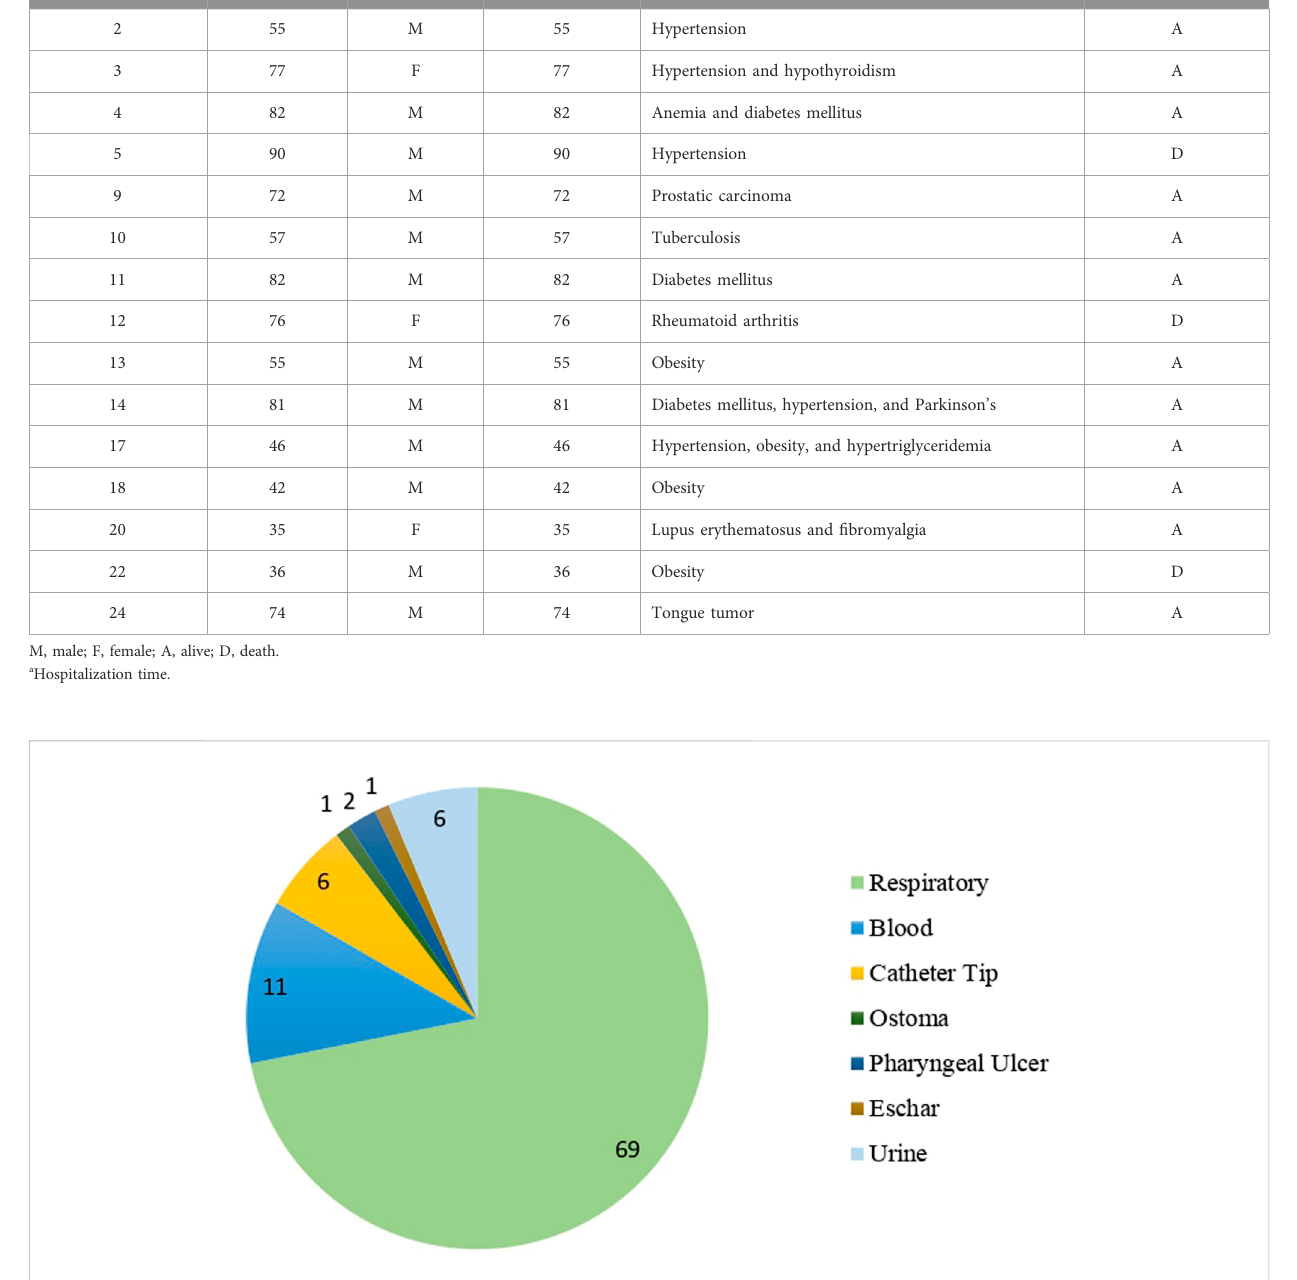
Type of samples used for the diagnosis of